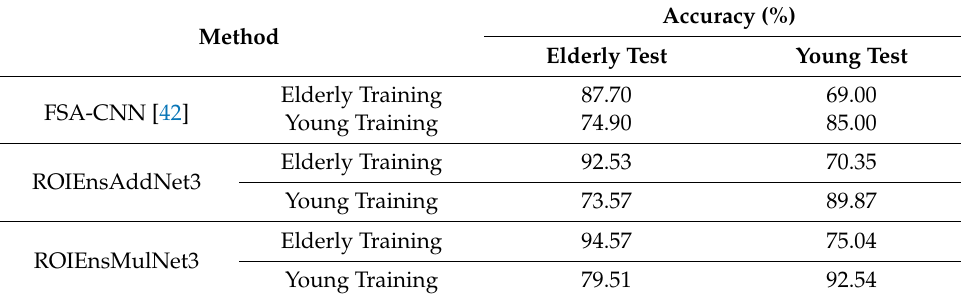
Table 6. Ensemble results (CA) of ROI-based